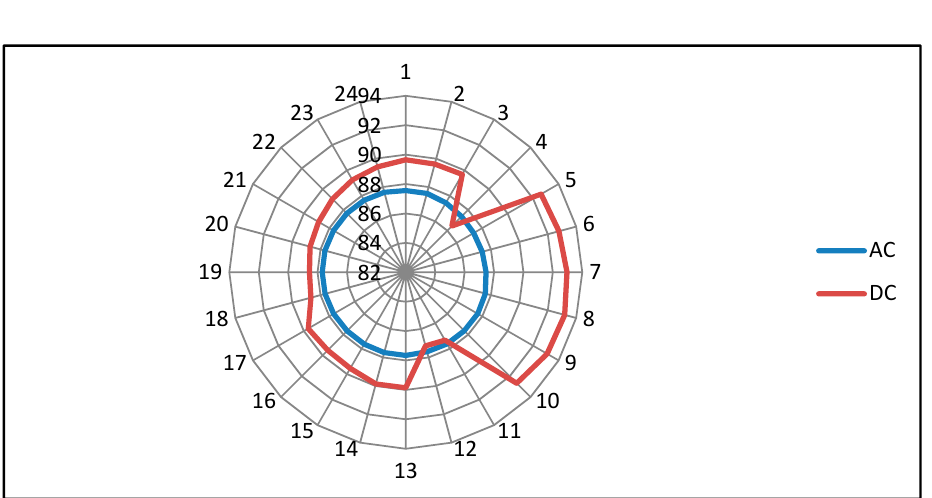
Figure 3. Loading vs . efficiency curves of ( a ) DC-DC converters [34], ( b ) AC-DC converters [35], ( c ) DC-AC converters [36], and ( d ) AC-AC transformers [37]. 𝜂 (𝑙) = (cid:3533) 𝑘 (cid:3036) × (𝑙 − 10𝑖) × 𝑢(𝑙 − 10𝑖) (cid:3037) (cid:3036)(cid:2880)(cid:2868)